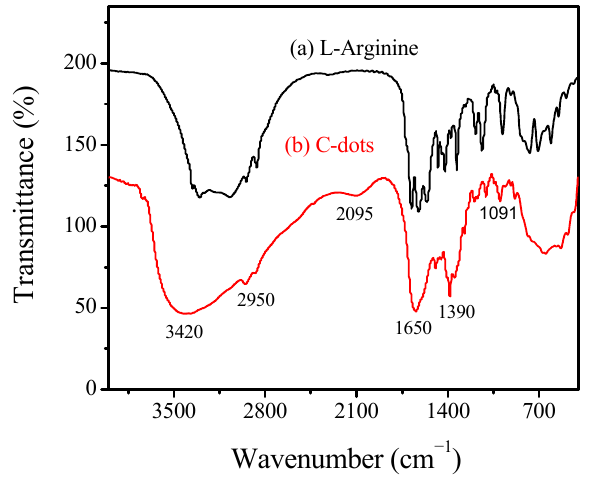
Figure 3. The FT-IR spectra of C-dots and L-arginine.